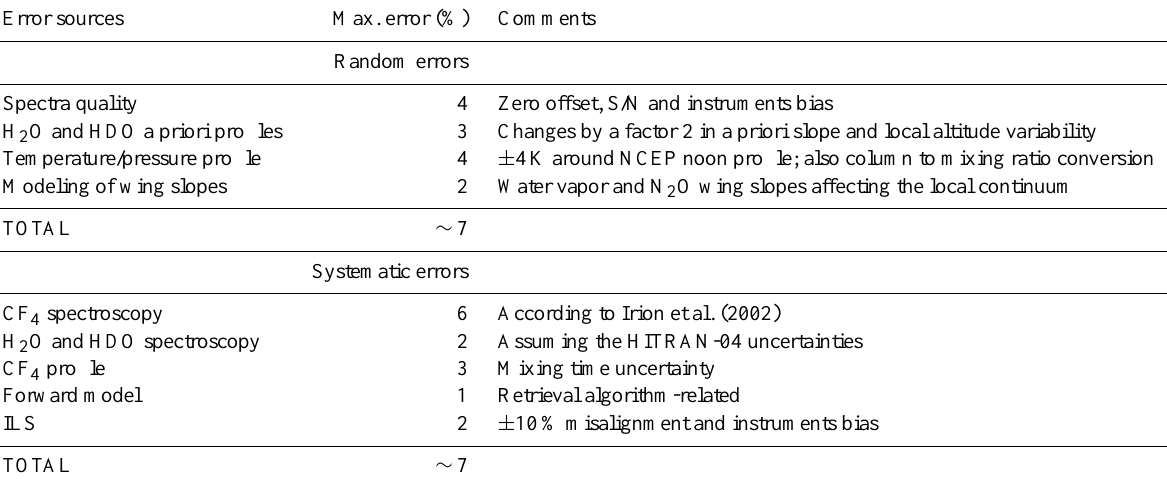
Table 1. Major sources of random and systematic errors on typical individual CF 4 total column retrievals above the